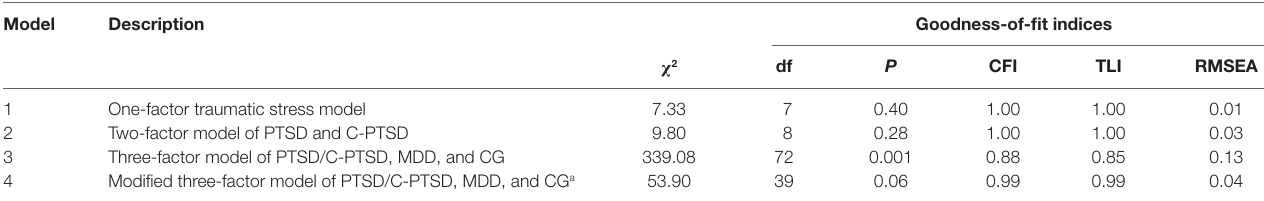
TaBle 2 | goodness-of-fit indicators for factorial models involving single and multiple disorder symptoms of PTsD, c-PTsD, MDD, and cg. Model Description